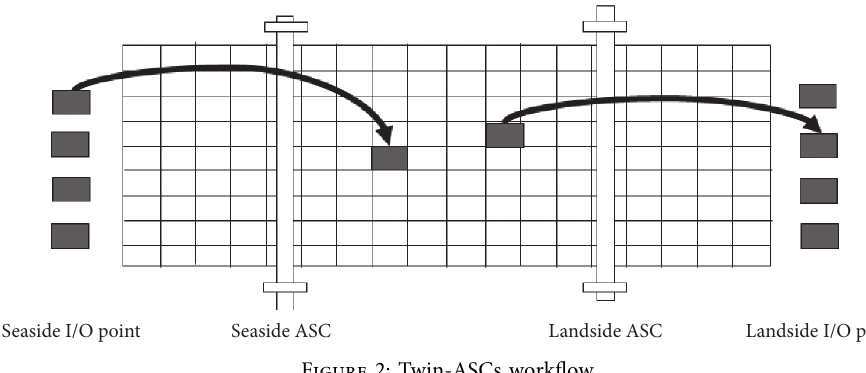
Figure 2: Twin-ASCs workflow.